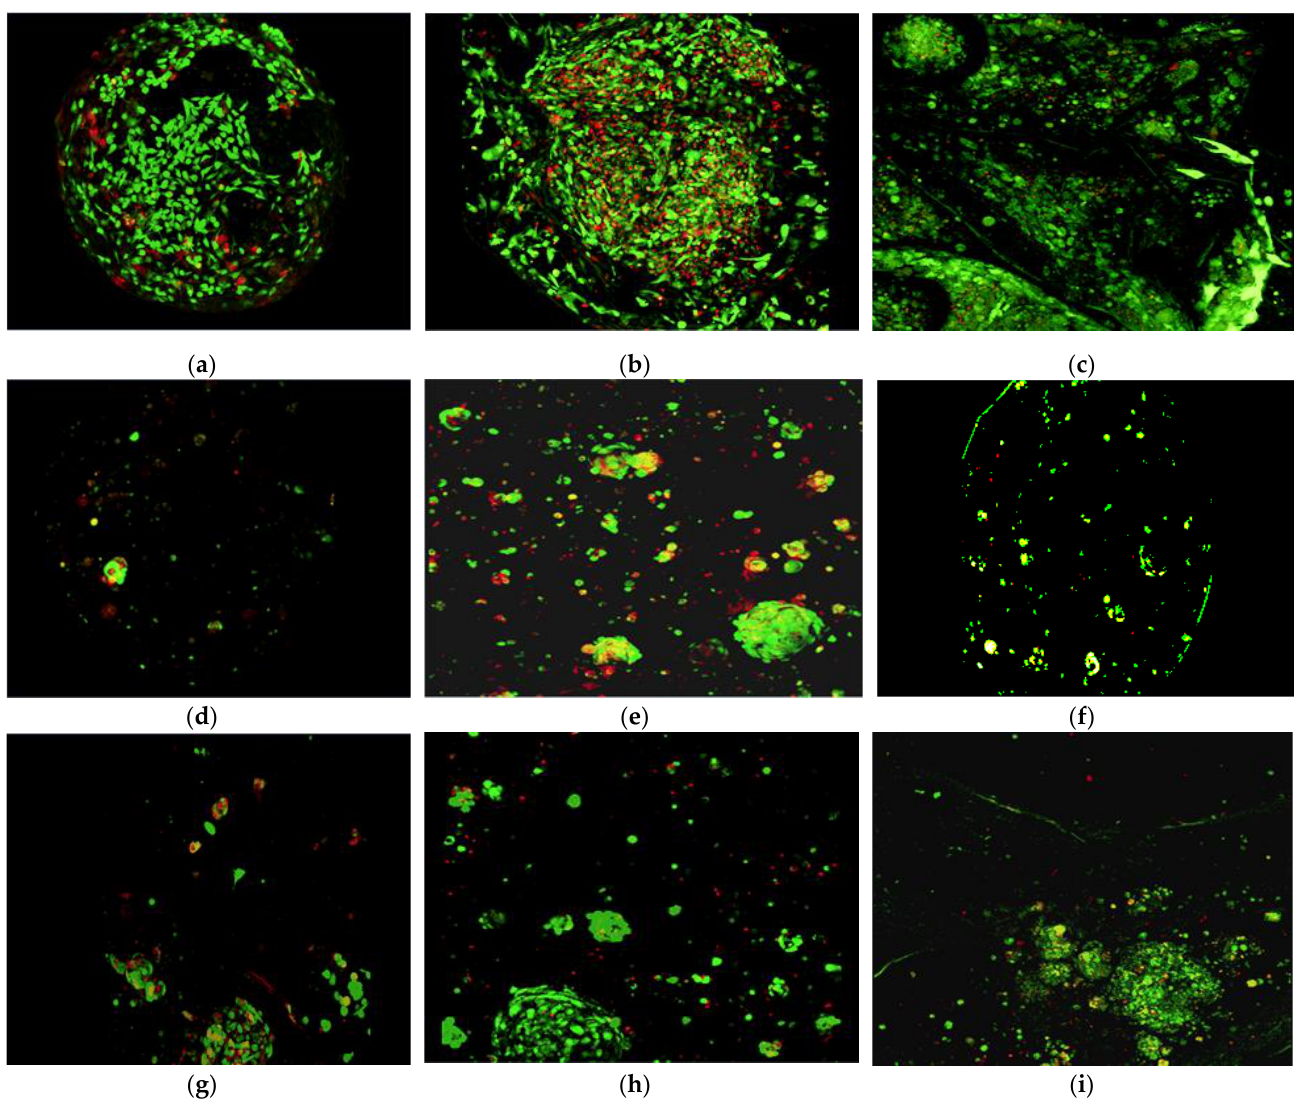
Figure 12. Confocal live/dead fluorescence images of the 90-day encapsulation culture. ( a – c )